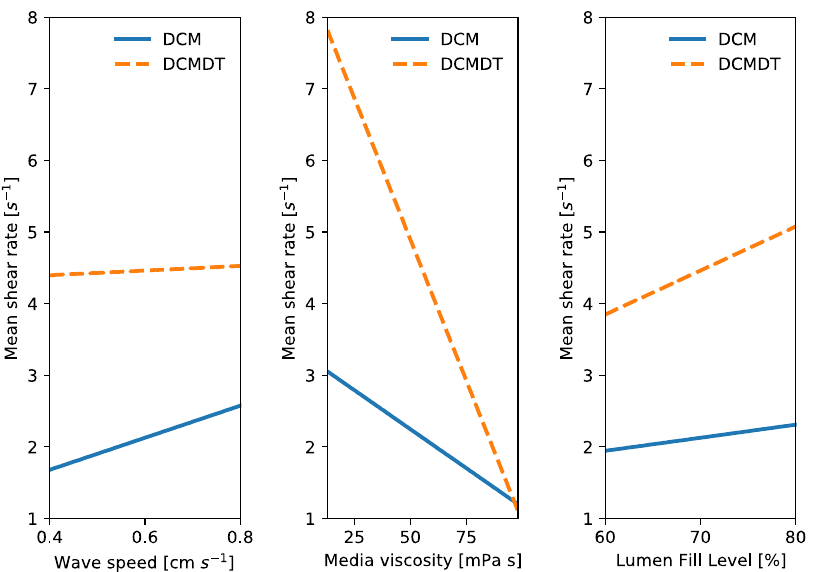
Figure 14. Main effects of wave speed, media viscosity and volume on mean shear rate at the bottom wall during local wall contraction at segment 6 in the DCM and the COM. N = 4 mean data points at each level (low and high).